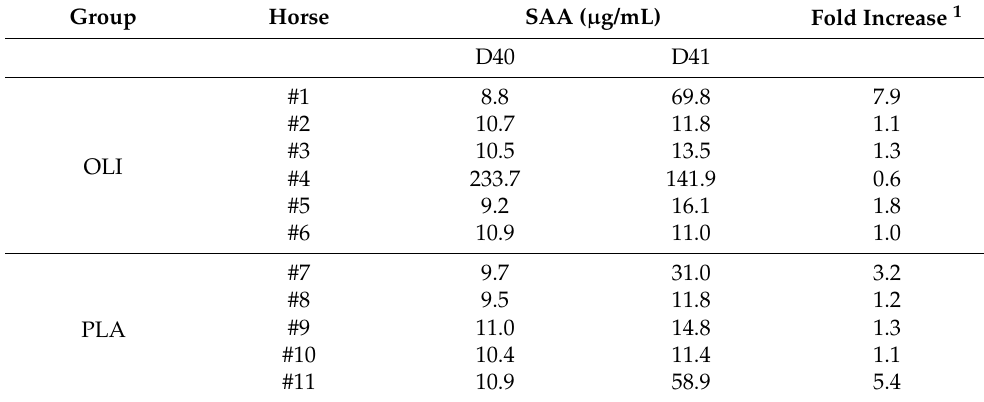
Table 2. Serum Amyloid A concentrations before and 24 h after vaccination.